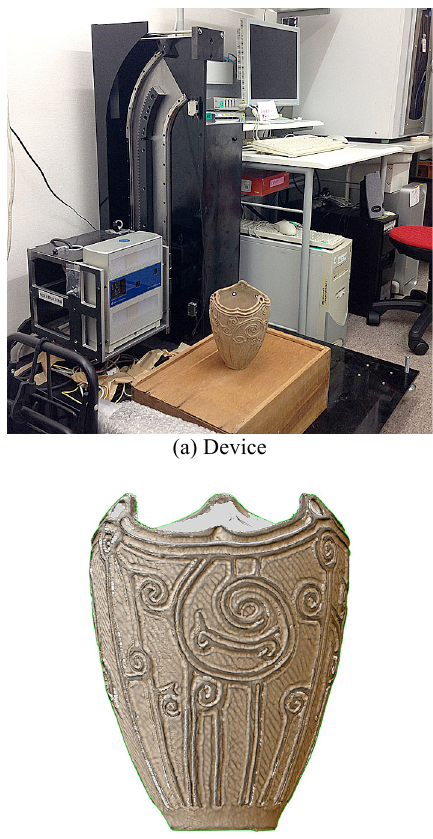
Figure 11. Rotational 3D measurement device